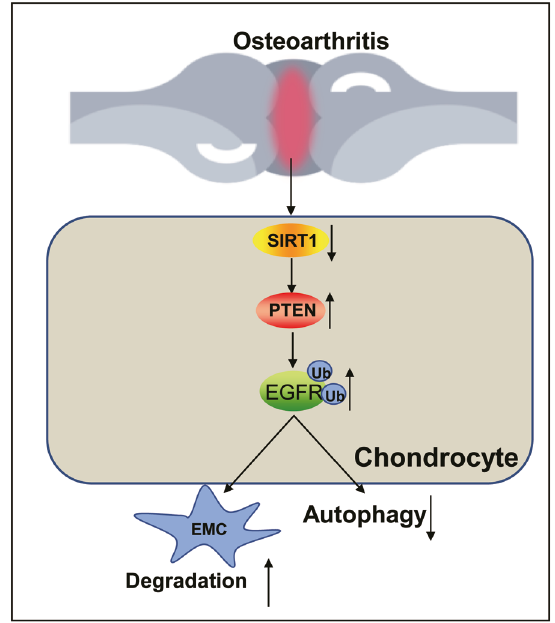
Fig. 8 The mechanism graph of the regulatory network and function of SIRT1. SIRT1 inhibits the ubiquitination of EGFR by down-regulating PTEN, thereby inhibiting the degradation of extracellular matrix cartilage and activating chondrocyte autophagy, thereby conferring a protective role against OA. EMC, extracellular